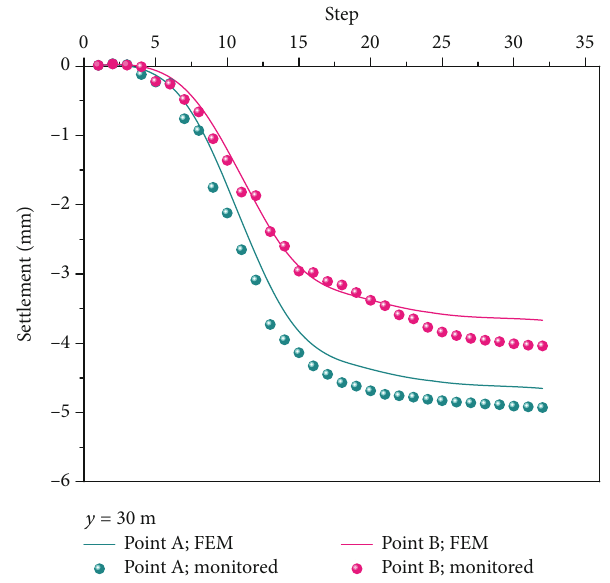
Figure 8: Settlements at Points A and B by the fi nite element method (FEM) and in situ monitoring.